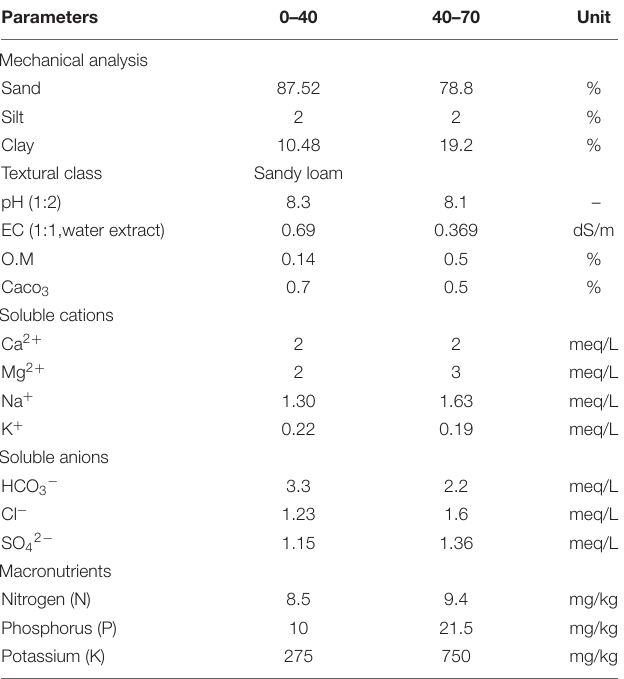
TABLE 1 | Physicochemical analysis of the experimental soil. Parameters